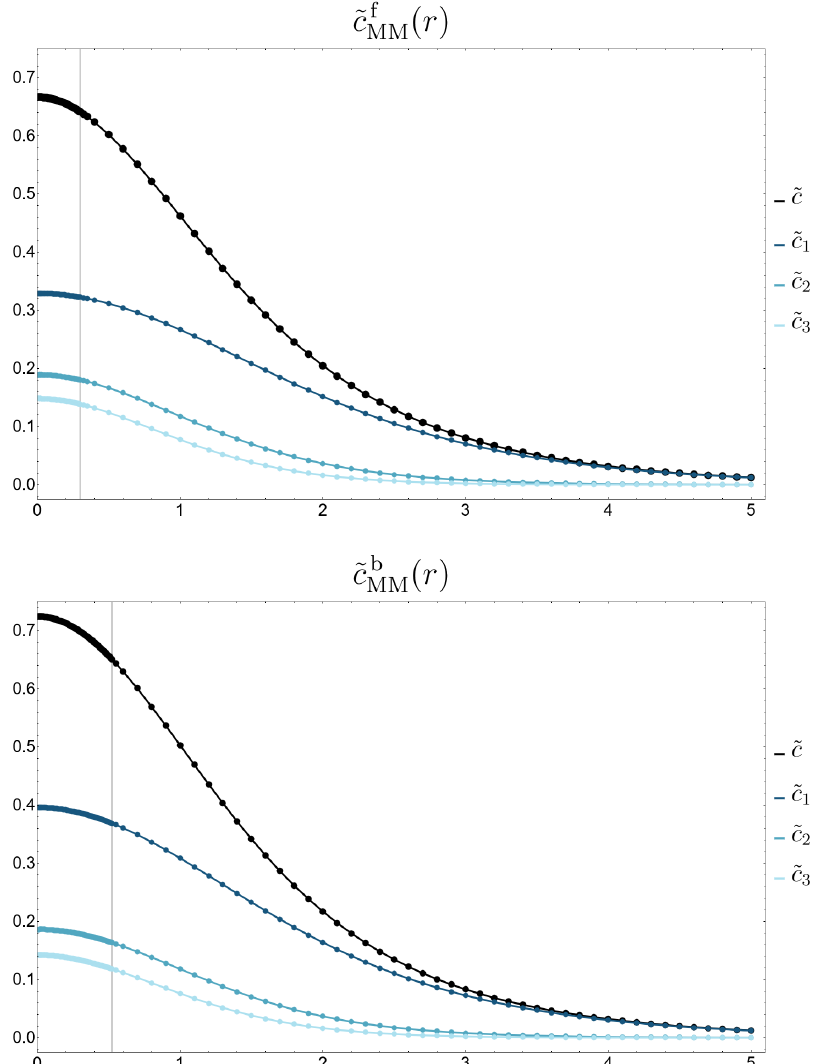
Figure 10. Effective central charge (black) for the Φ 1 , 3 deformed minimal model M 2 , 2 n +3 with n = 3 , in its fermionic (top) and bosonic (bottom) flavours. The blue curves refer to the single particle contributions ˜ c a ( r ) as in equation (5.6). The vertical gray line shows the radius r ∗ where the iterative method becomes unstable. For r < r ∗ we use the pseudo arclength numerical method. The effective central charges converge in the ultraviolet to 2 / 3 in the fermionic model and to 0 . 724253 in the bosonic